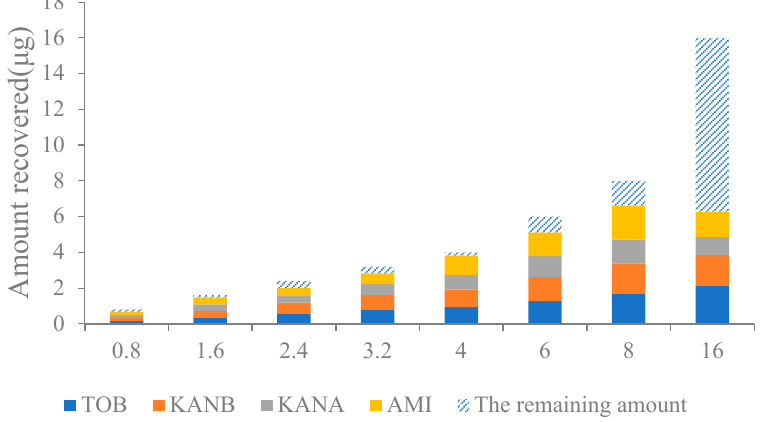
Figure 5. Effect on analyte recoveries of the capacity of AAC column.